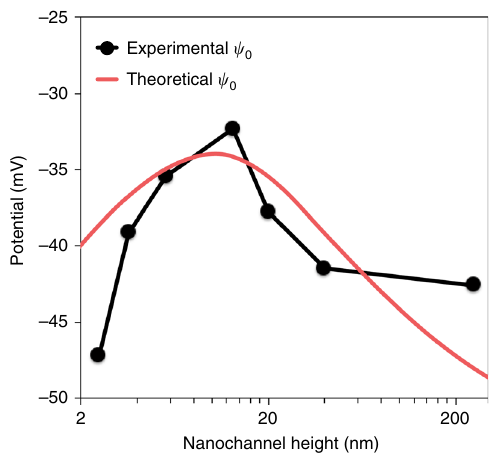
Fig. 4 Experimental and theoretical surface potentials. Surface potential ψ 0 as a function of nanochannel height computed with the site-binding model for the silica surfaces (red line). Experimental measurements of the surface potential obtained through the streaming potential method (black dots) using a 50 mM NaCl solution